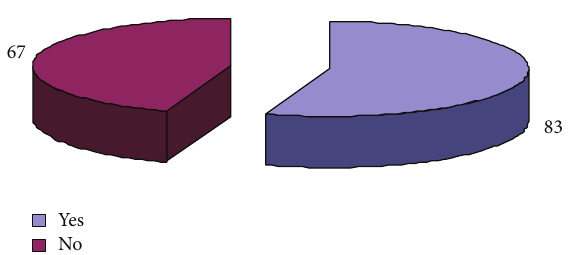
Figure 24: Showing the distribution of patients in accordance with complaints of